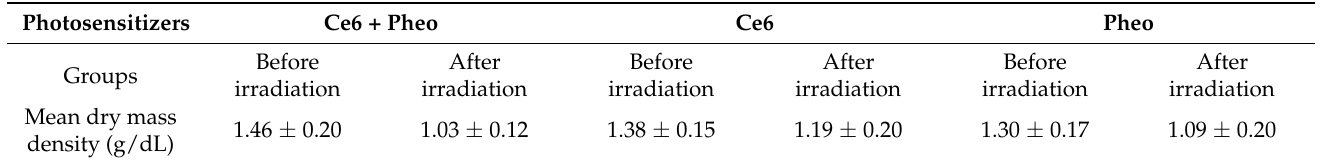
Table 3. The averaged dry mass density with standard deviation before and after irradiation for all analyzed photosensitizers.